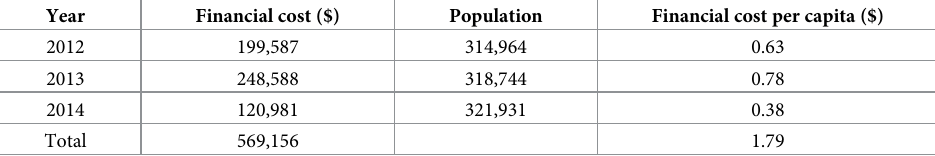
Table 3. Financial cost of implementing GEHIP